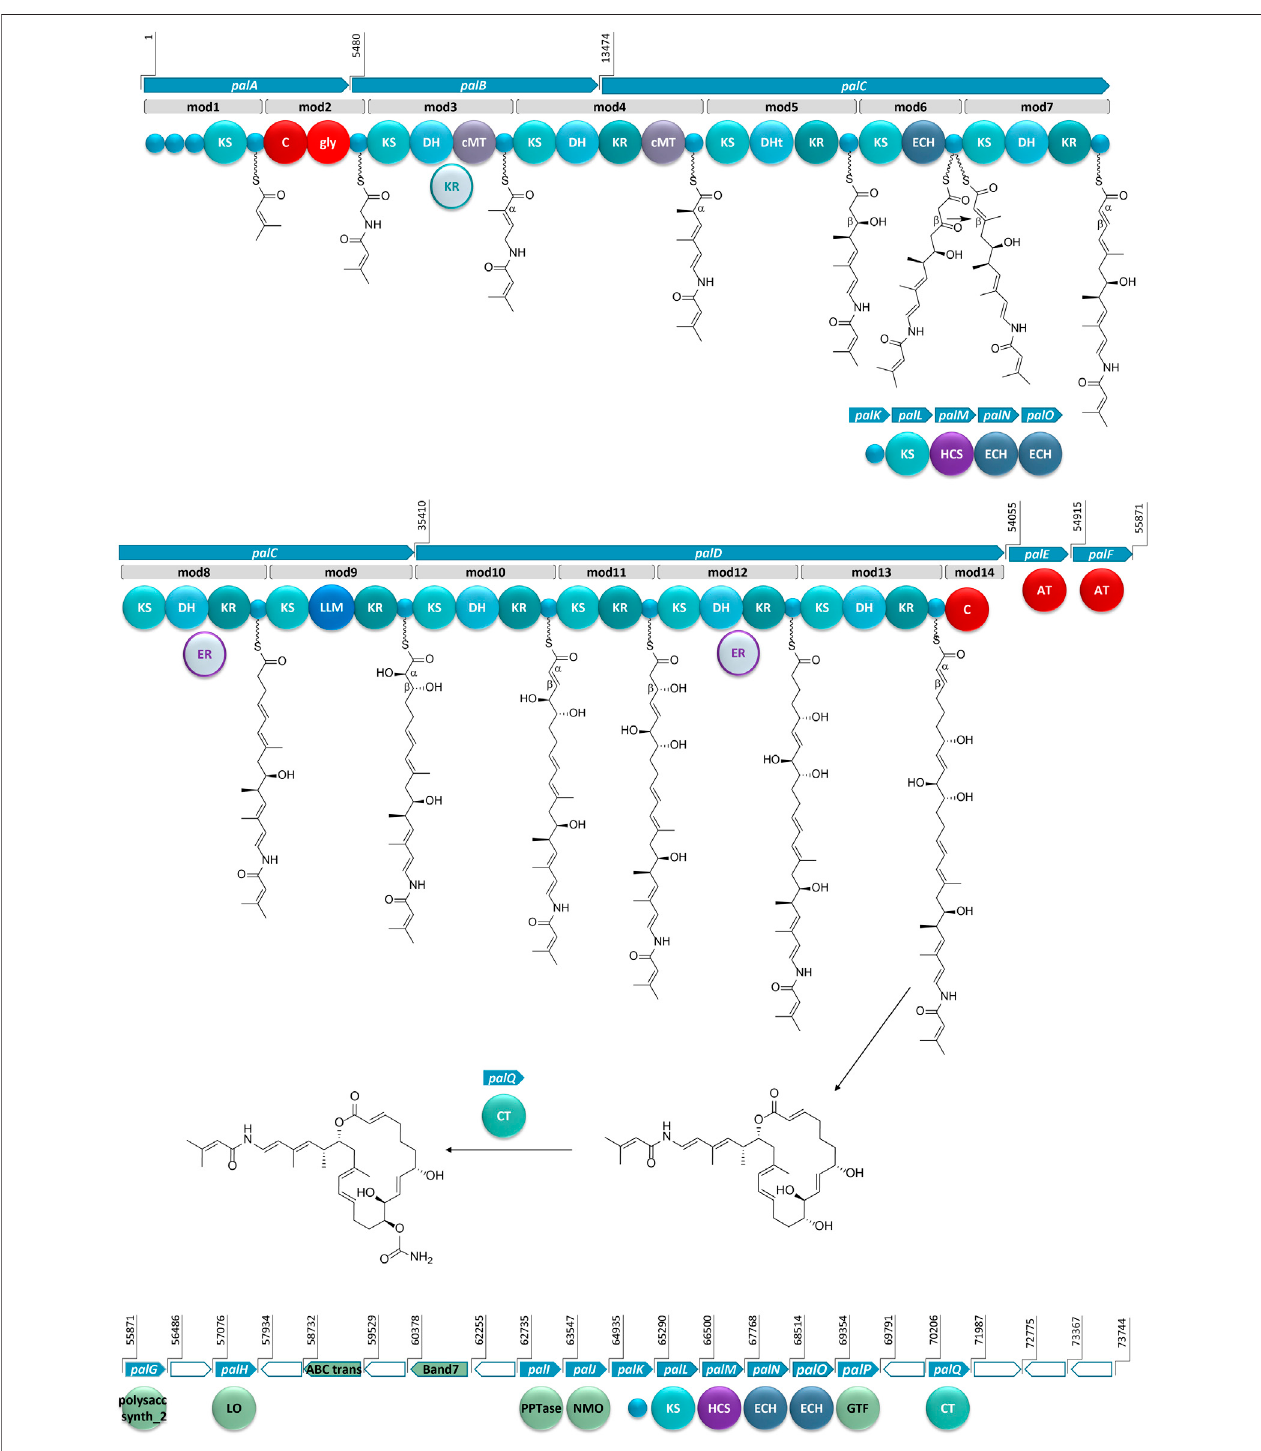
FIGURE 3 | The proposed BGC for palmerolide A, showing the hybrid PKS-NRPS system. KS: ketosynthase domain, C: condensation domain, gly: adenylation domain for glycineincorporation,DH: dehydratase domain, cMT: carbon methyl transferase domain, KR: ketoreductasedomain, DHt:dehydratasevariant; ECH: enoyl- CoA hydratase,LLM:luciferase-like monooxygenase,AT:acyltransferase;polysacc synt_2:polysaccharidebiosynthesisprotein,LO: lactoneoxidase,ABCtrans:ATP- binding cassette transporter, Band7: stomatin-like integral membrane, PPTase: phosphopantetheinyl transferase, NMO: nitronate monooxygenase, HCS: hydroxymethylglutaryl-CoA synthase, GTF: glycosyl transferase ER: enoyl reductase, CT: carbamoyl transferase, small blue circles represent acyl- or peptidyl-carrier proteins. Ppant arms are symbolized by wavy lines. The grey domains (the KR in mod3 and ERs in mod8 and mod12) indicate domains that would be expected to performanenzymatictransformation;however,arenotencodedintheBGC.Bluearrowsindicatebiosyntheticgenes.Greenarrowsindicategenesthatencodefornon- biosynthetic proteins. White arrows re fl ect genes that encode for hypothetical proteins. The BGC is displayed in reverse compliment.